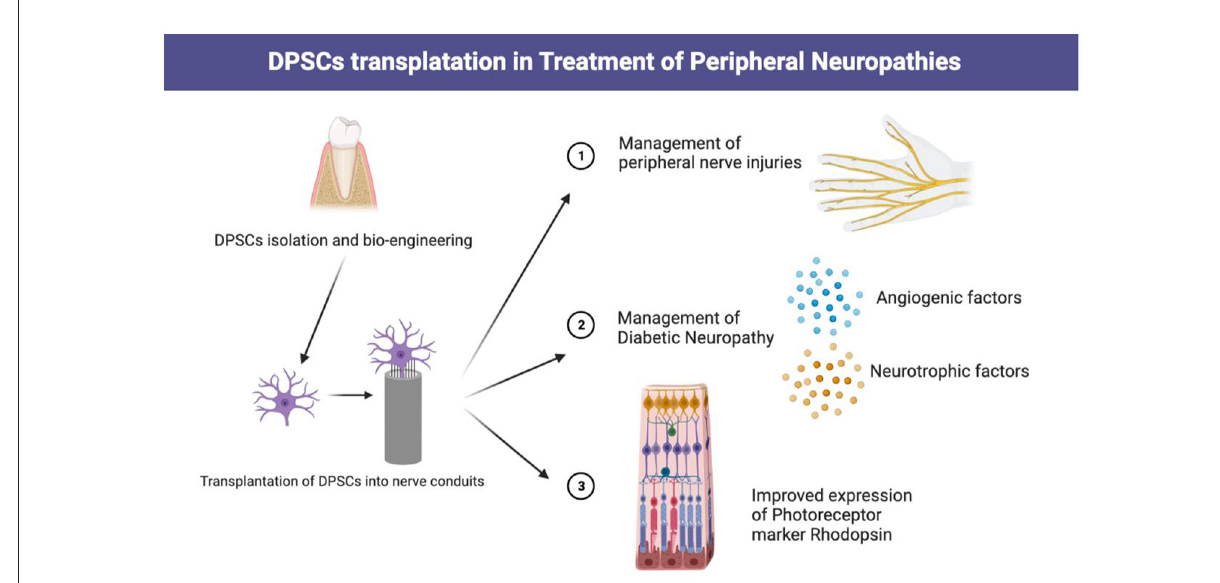
FIGURE3 Transplantation of DPSCs in management of various peripheral